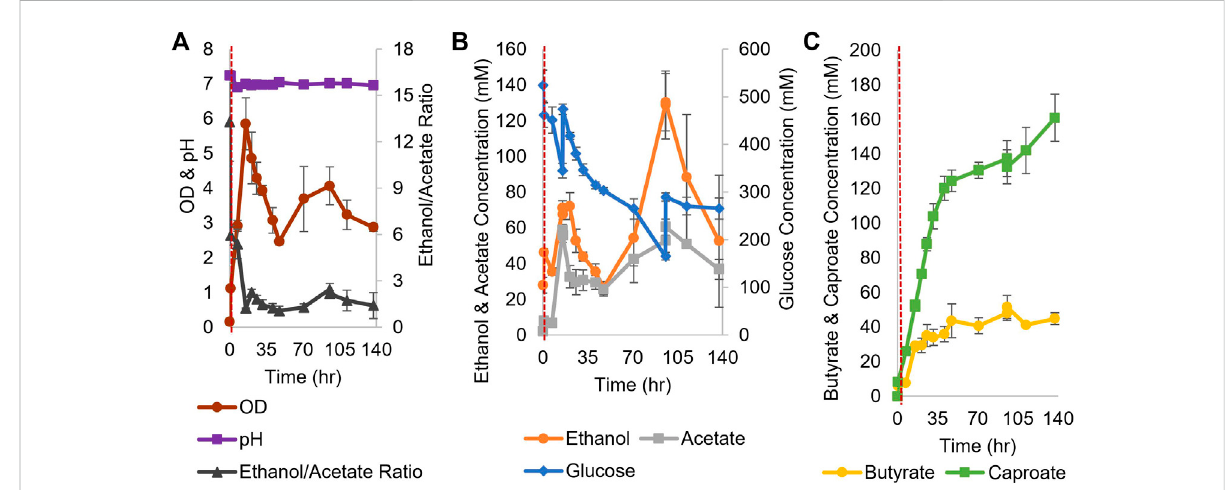
FIGURE 6 Growth and metabolite pro fi les of Csh and Ckl cocultures in pH-controlled bioreactors. (A) The OD 600 and pH. The pH remained atits setpoint of 7 ( n = 3 biological replicates). (B) shows the glucose pro fi le and consumption (glucose was added twice; note the second axis) and the pro fi les of ethanolandacetateproducedby Csh . (C) showsthepro fi lesofthebutyrateandcaproateproducedby Ckl inthecoculture.Notethatmostcaproate is produced in the initial 35 h, but that production continues until the end of the fermentation with an increase pro fi le slope indicative of continued caproate production. The red dashed vertical line indicates Ckl